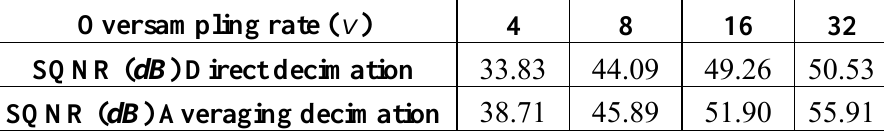
Table 2. SQNR improvement at different oversampling